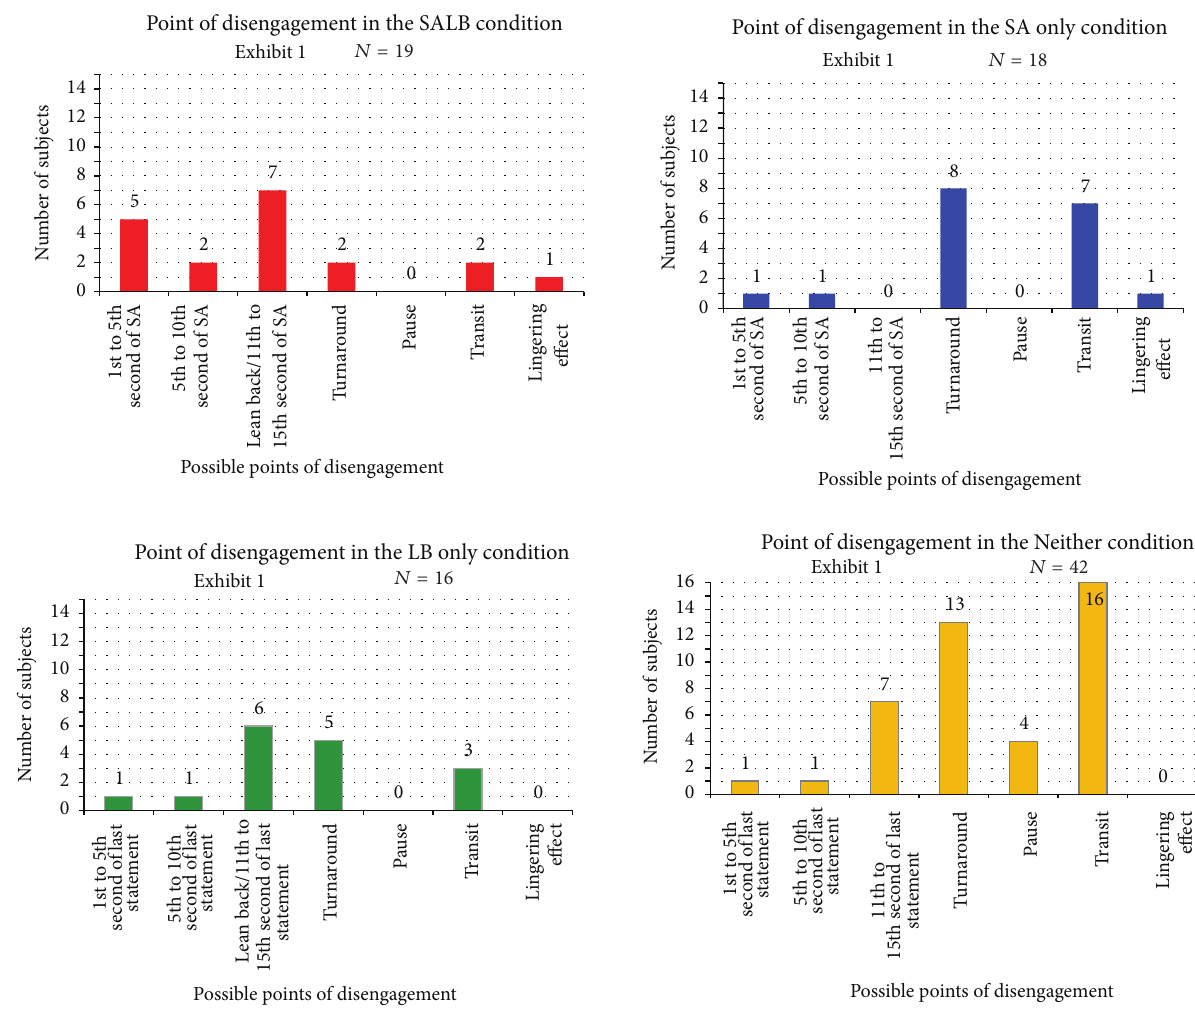
Figure 10: Points of disengagement in the four conditions at exhibit 1.